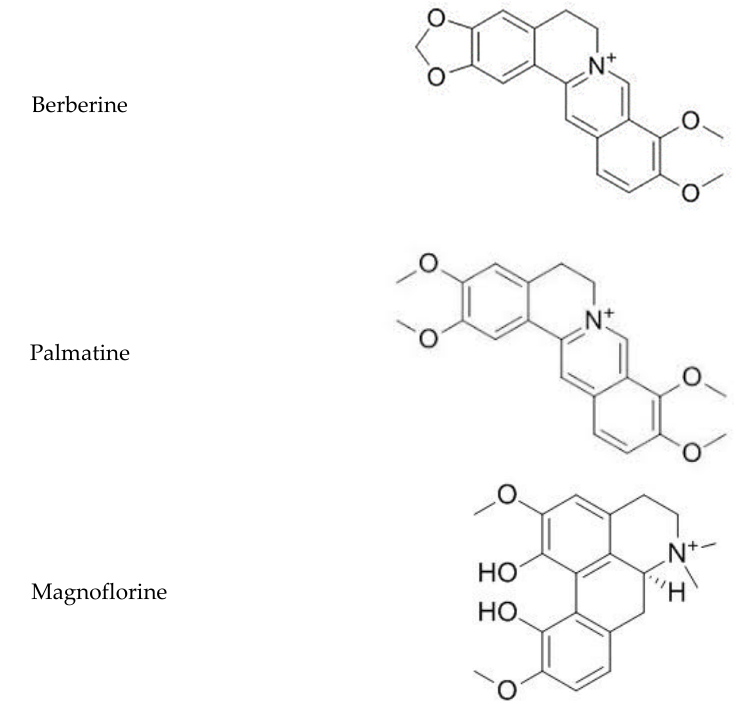
Figure 1. Chemical structures of investigated isoquinoline alkaloids. Table 1. Retention times and equation of calibration curve, correlation coefficients (r), limit of de- tection (LOD) and limit of quantification (LOQ) values for studied isoquinoline alkaloids. Equation of Calibration Alkaloid t R Curve